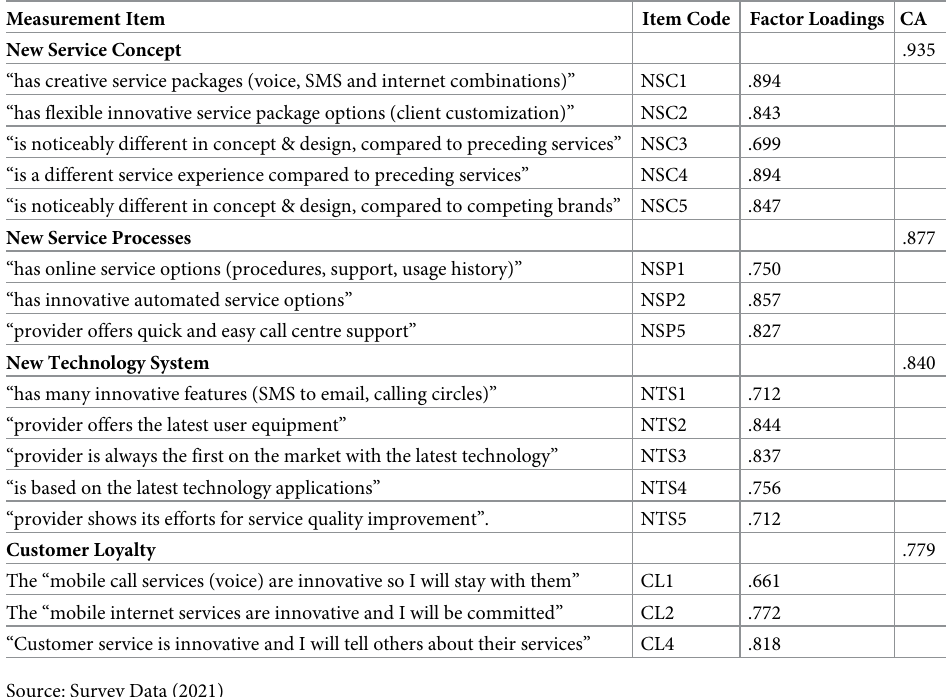
Table 1. Reliability and validity test result.